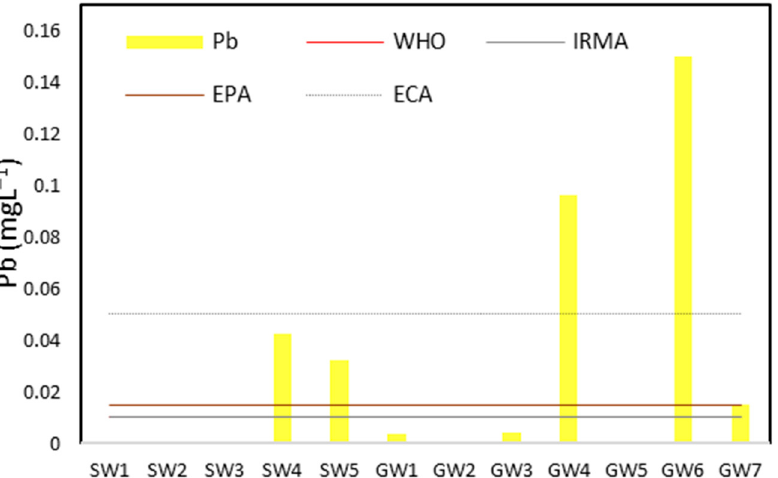
Figure 5. Lead concentrations in surface water (SW) and groundwater (GW) were obtained within the samples that were examined.